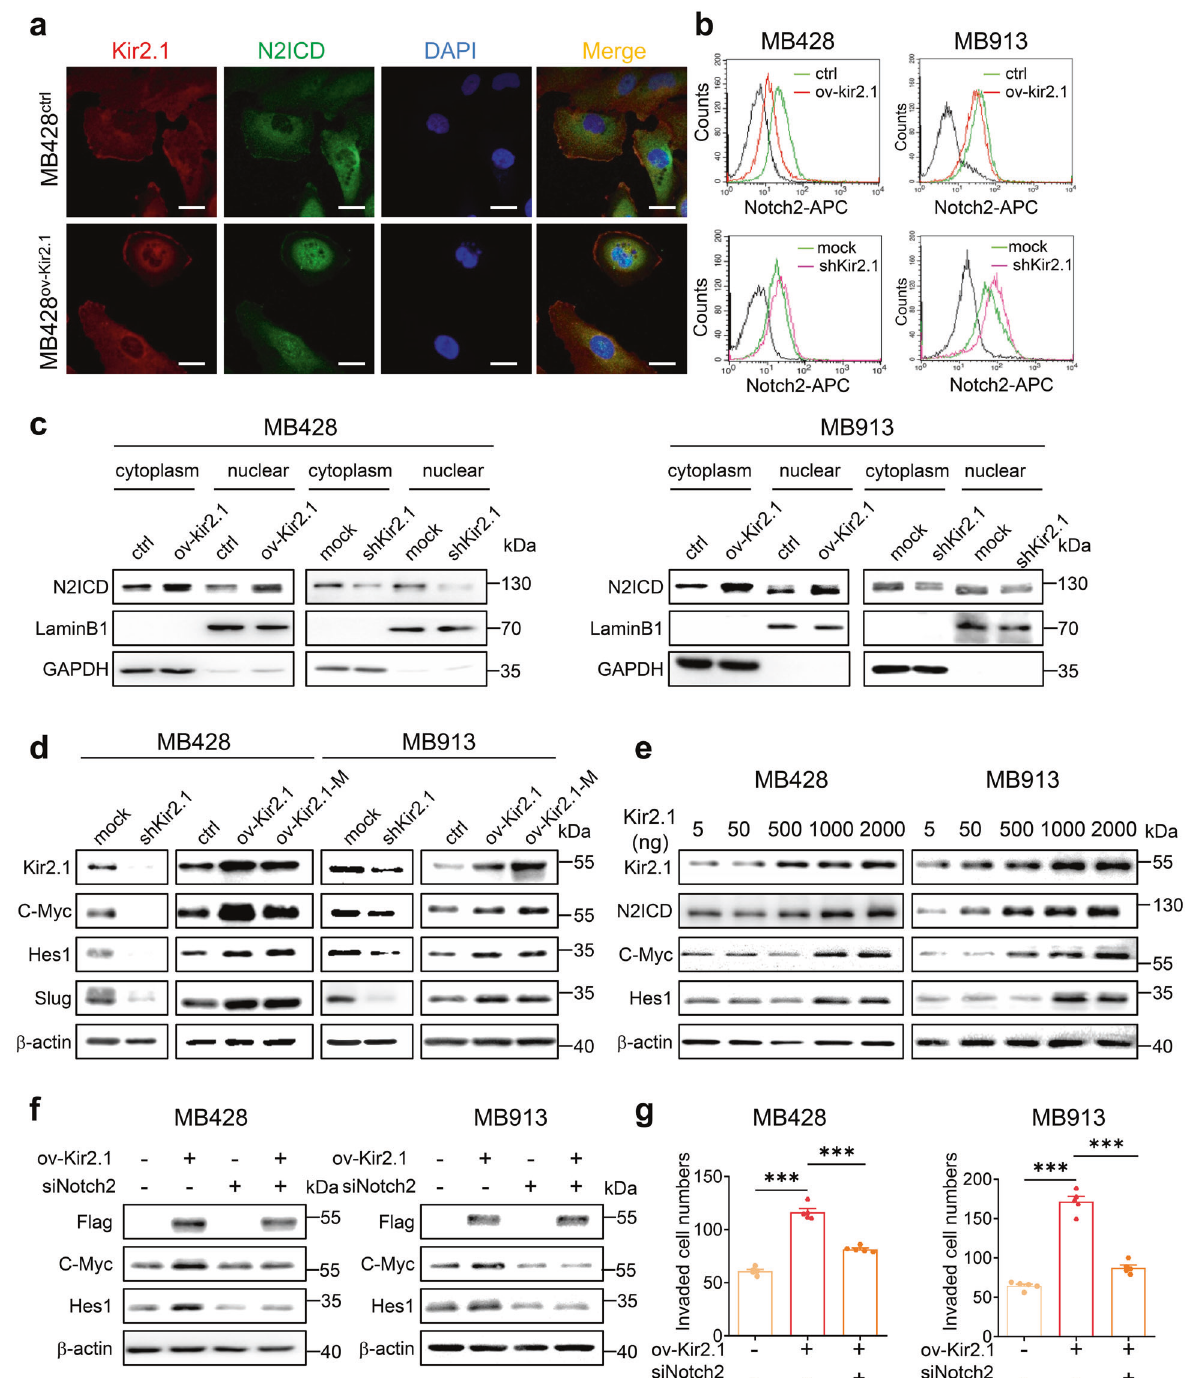
Fig. 4 Kir2.1 activates Notch2 signaling in non-WNT/SHH MB cells. a Immuno fl uorescence assays showing that overexpressing Kir2.1enhanced intracellular domain of Notch2 (N2ICD) in the cytoplasm and nuclei in MB428 cells. Scale bar = 20 μ m. b FACS showing that overexpressing Kir2.1 decreased cell surface Notch2, whereas silencing Kir2.1-enhanced cell surface Notch2 in MB428 and MB913 cells. c Western blotting showing that overexpressing Kir2.1-enhanced N2ICD, whereas silencing Kir2.1 reduced N2ICD in both the cytoplasm and nuclei in MB428 and MB913 cells. d Western blotting showing that manipulating the expression of Kir2.1 signi fi cantly altered the expression of Notch2 pathway- targeted genes C-Myc , Hes1, and Slug in MB428 and MB913 cells. e Western blotting showing that transiently transfecting of Kir2.1- overexpressing plasmid altered the expression of Notch2 pathway-targeted genes in dose-dependent manner. f Western blotting showing that knockdown of Notch2 attenuated Kir2.1-induced expression of C-Myc and Hes1 in MB428 and MB913 cells. Here, anti-Flag antibody was used to bind Flag-tagged Kir2.1 in Kir2.1-overexpressing cells. g Matrigel-transwell invasion assays showing that knockdown of Notch2 attenuated Kir2.1-promoted invasion in MB428 and MB913 cells. Data are shown as the mean ± S.D., n = 5, ns, not signi fi cant, *** P < 0.0001, ANOVA